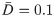
Effects of GSD on melting kinetics under constant temperature T = 1128 K.(a) Plots for fixed D¯=0.1 cm and various k; (b) Plots for fixed k = 2.5 and various D¯.